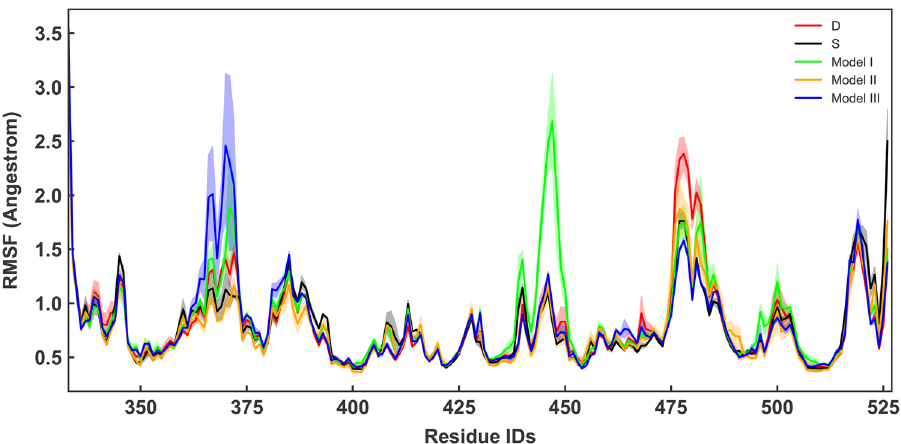
Figure 4. RMSF per residue of RBD calculated from all replicates of each system and are shown for model S (black), model I (lime), model II (orange) and model III (blue). Light shades around each plot presents standard error for each calculation. RMSF of model D is shown in